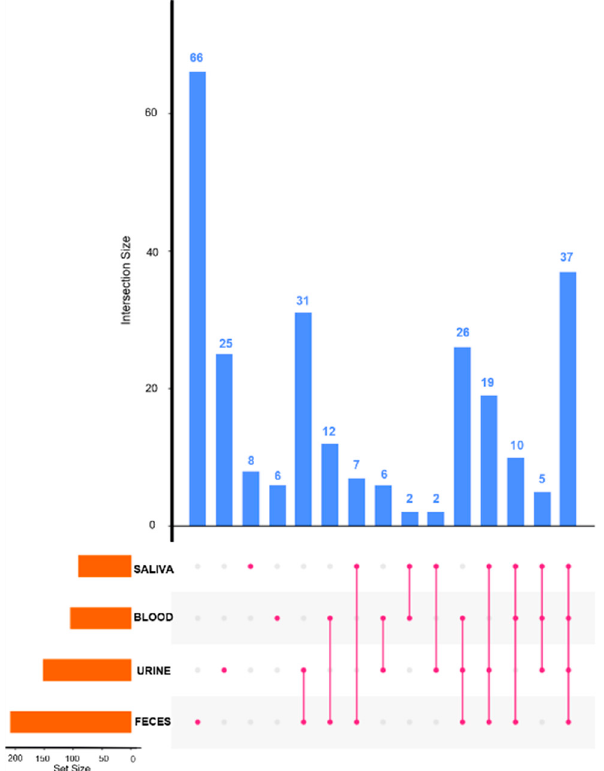
Figure 3. Upset diagram to show the complementarity in term of metabolite coverage across the differ- ent biological matrices (Set Size = number of total compounds per matrix, Intersection Size = number of compounds detected in different